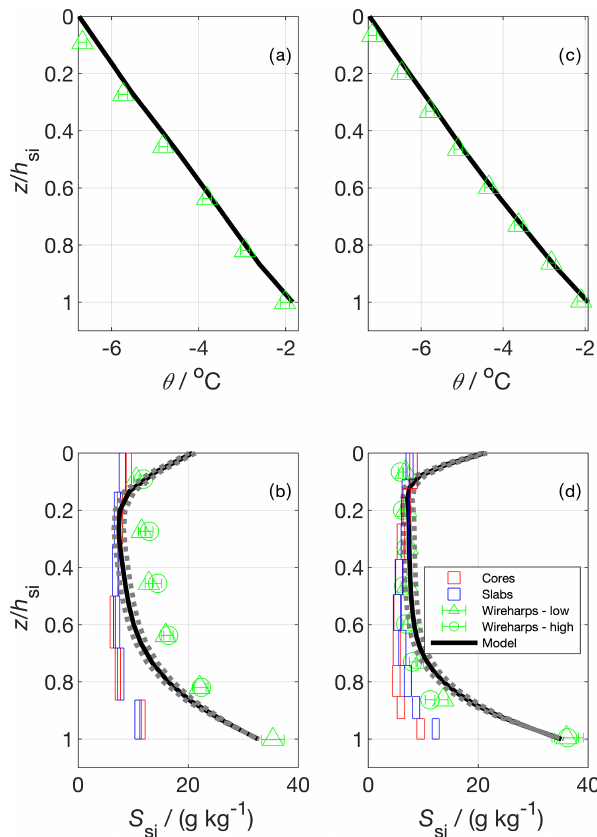
Figure 11. Vertical temperature ( a and c ) and bulk salinity profiles ( b and d ) for two experimental runs. In (a) and (c) the model tem- perature shows the model forcing, which was produced using mea- sured temperature profiles; panels (b) and (d) show salinity esti- mated from cores, slabs (Cottier et al., 1999), wireharps (Notz et al., 2005), and a gravity drainage model. The horizontal box length shows the median 1 standard deviation from repeat measurements at a given depth (cores and slabs), and the vertical box length shows the depth covered by the sample layer. Wireharp errors were cal- culated using methodology presented in Zeigermann (2018). The model used the Griewank and Notz (2013) gravity drainage param- eterisation with tuning parameters taken from Griewank and Notz (2015). The solid line represents their best estimate tuning parame- ter set. The dotted bounds on the model show output using two other plausible sets of tuning parameters presented in Griewank and Notz